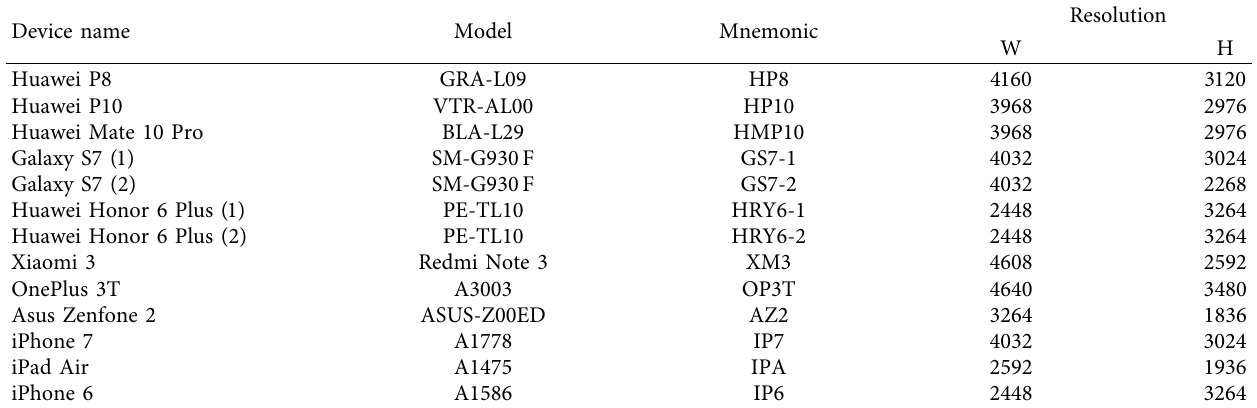
Table 3, the method proposed by Quintanar-Res´endiz et al.